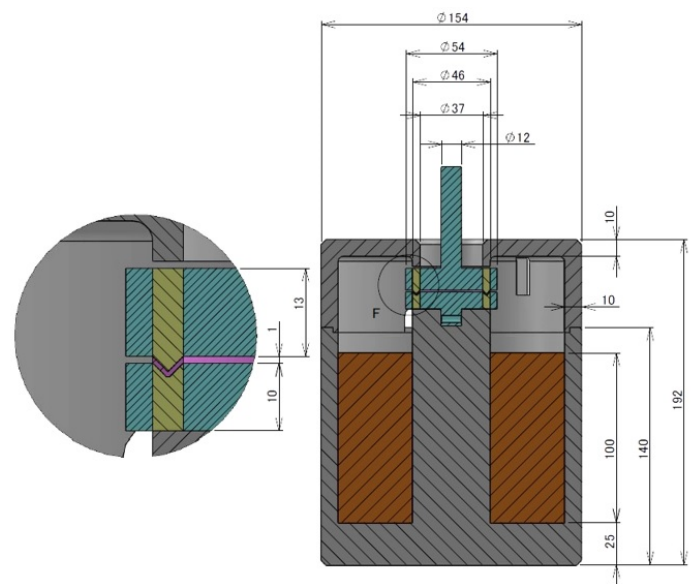
Figure 5. Test cell for V-shaped plate setting. Circle F is the closeup part.